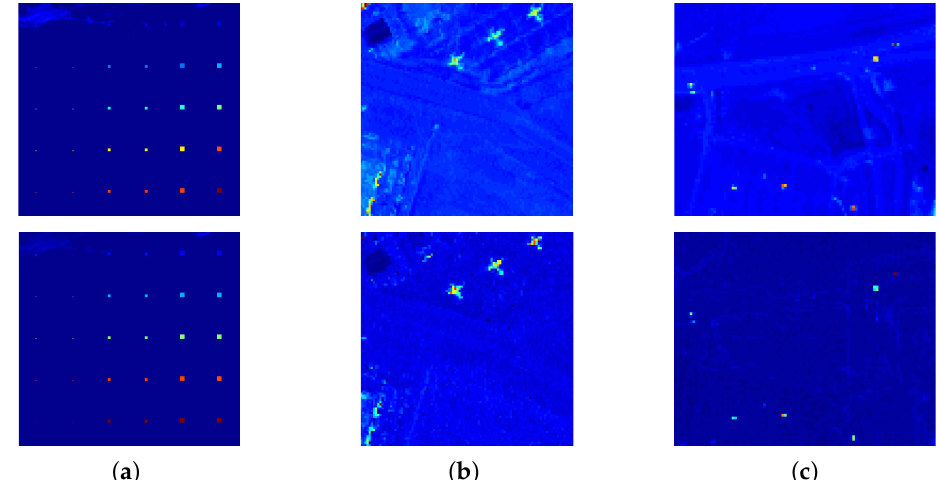
Figure 11. Effect of adaptive weighting on the detection map obtained by DCLaAW for each dataset. For each dataset, the top is the DCLaAW without adaptive weighting and the bottom is the DCLaAW with adaptive weighting. ( a ) Synthetic dataset; ( b ) San Diego dataset; ( c ) Urban